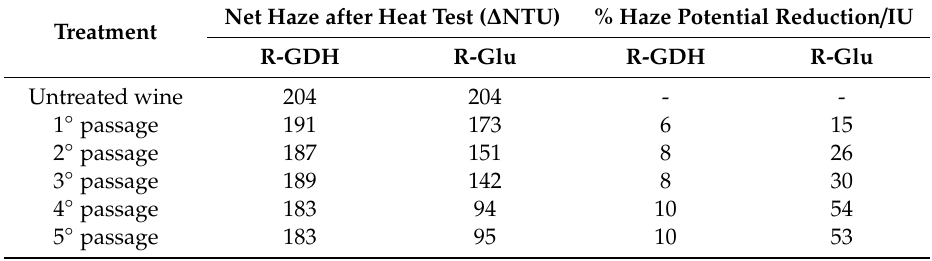
Table 3. Haze potential of Sauvignon blanc wine treated for five passages in the same packed-bed reactor containing bromelain immobilized on Relizyme EP403 / S-GDH or Relizyme EP403 / S-glucosamine at 20 ◦ C. Net Haze after Heat Test ( ∆ NTU) % Haze Potential Reduction / IU Treatment R-GDH R-Glu R-GDH